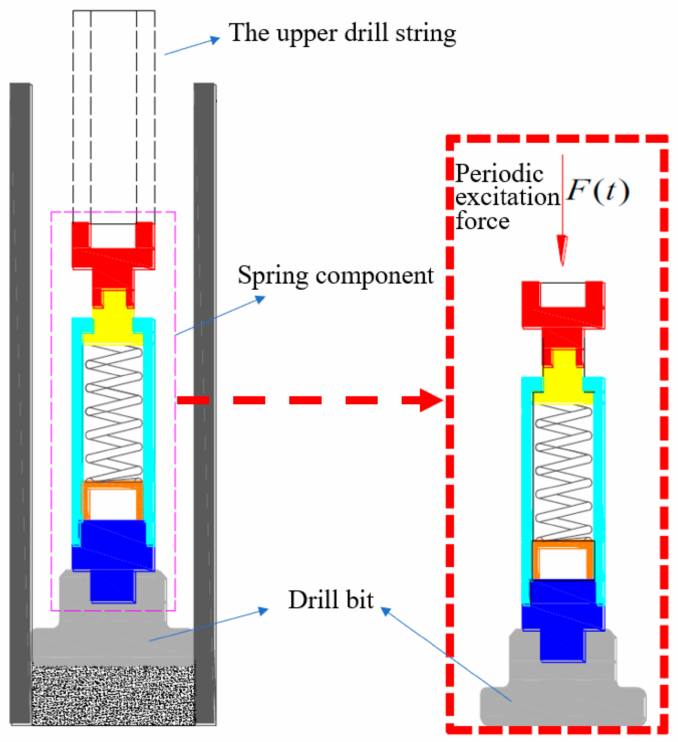
Figure 16. Schematic diagram of the equivalent excitation force of the longitudinal vibration of the upper drill string of the spring